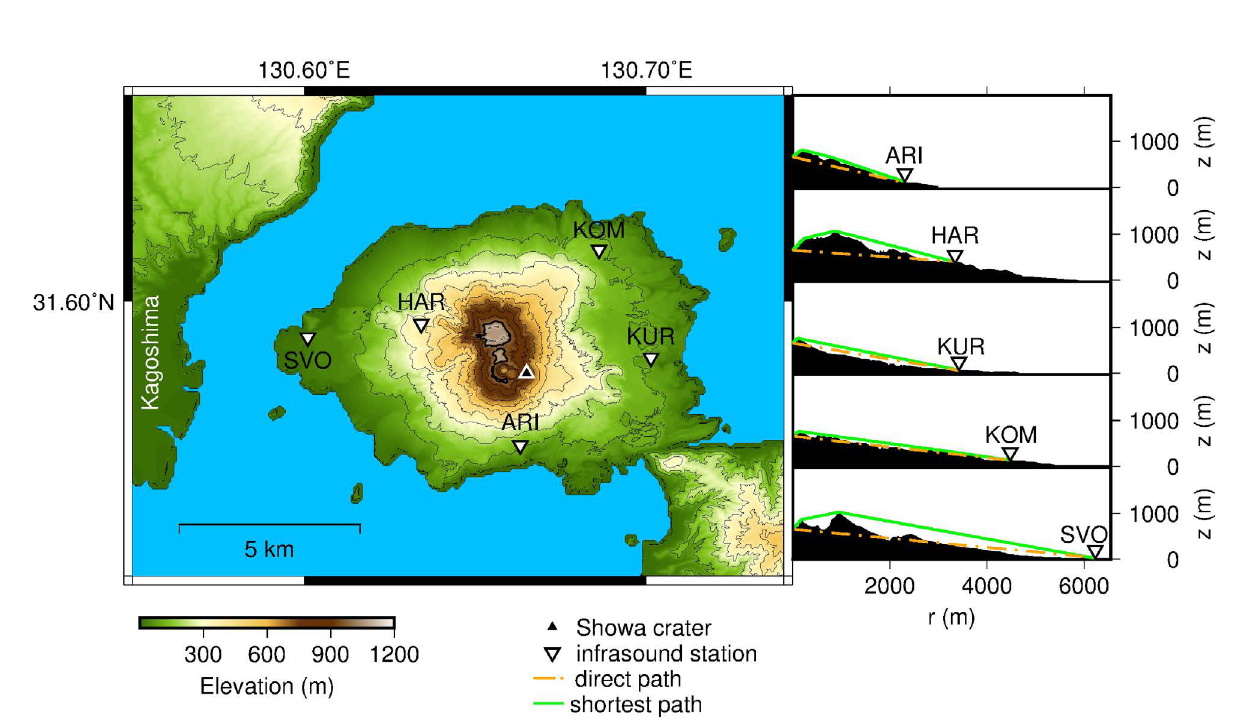
Figure 1: Map of Sakurajima Volcano in southern Japan with 1 m resolution around the crater and 10 m resolution around the perimeter (interpolated to 1 m resolution). Contours are marked at 200 meters and the 1000 meter contour is marked in bold. The active vent is in Showa crater (upward triangle). Downward triangles represent infrasound sensors deployed for eight days in 2013 [Fee et al. 2014]. Profiles at right show topography between the vent and each sensor. Dash-dotted and solid lines show the direct and shortest diffracted raypaths, respectively, with lengths corresponding to R d and R t in Equation 1,